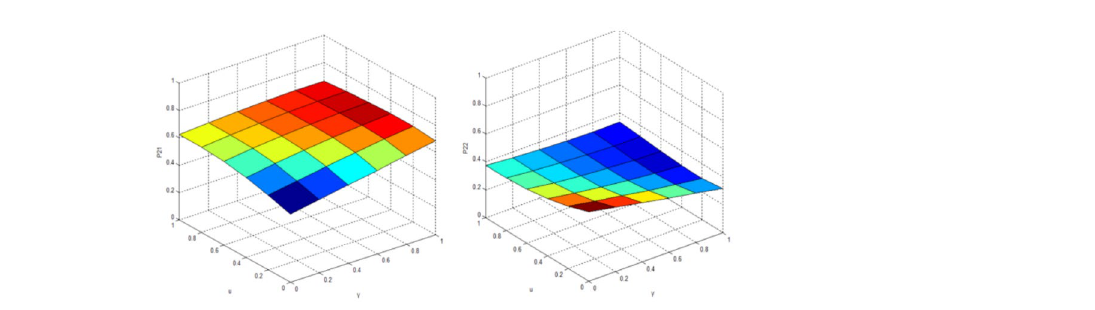
Figure 9. Probability of the target vehicle pass (left:P21)/yeild (right:P22) when knowing that interact vehicle intends to yeild (t =